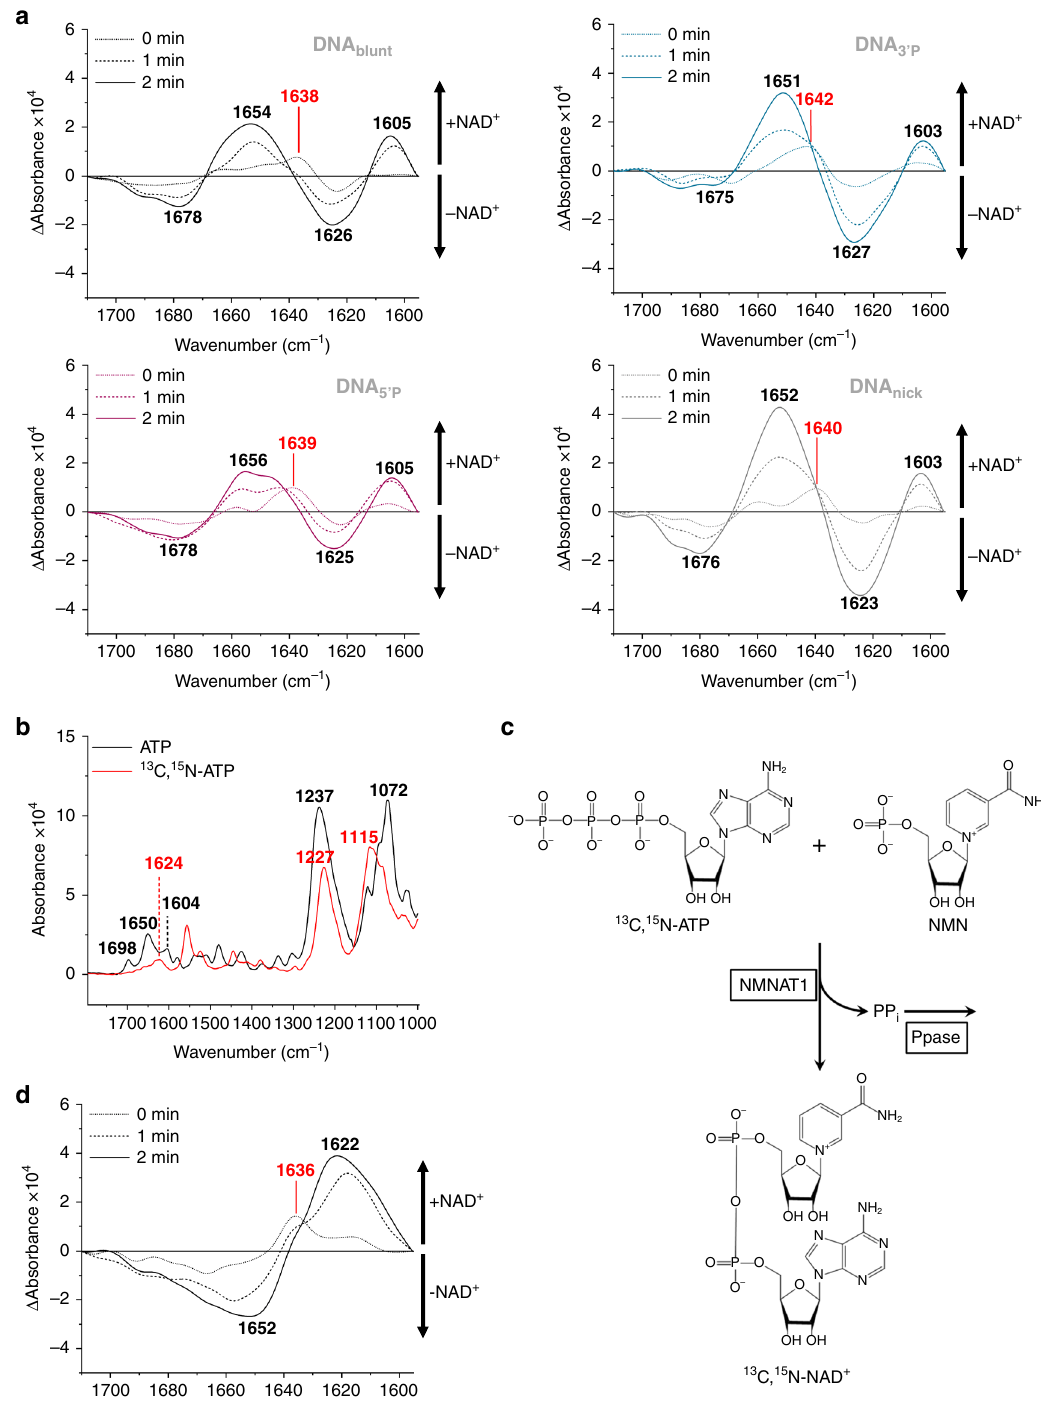
Fig. 5 Secondary structure analysis of PARP1 upon NAD + addition. a Comparison of PARP1 bound to immobilised DNA blunt , DNA 3 ’ P , DNA 5 ’ P or DNA nick . Difference spectra of amide I bands of PARP1 before and after the addition of 100 µ M NAD + (0, 1 and 2 min) were calculated. Average curves of n = 3 independent experiments are plotted, respectively. SDs are shown in Supplementary Fig. 4a. Positive difference bands distinct from PAR bands are indicated in red. b Spectra of unlabelled and isotopically labelled 13 C, 15 N-ATP. c Strategy for the enzymatic synthesis of isotopically labelled 13 C, 15 N-NAD + . d Difference spectra of amide I bands of PARP1 bound to DNA blunt before and after the addition of 100 µ M 13 C, 15 N-NAD + (0, 1 and 2 min) were calculated. Average curves of n = 3 independent experiments are plotted. SDs are shown in Supplementary Fig. 4d. The positive difference band distinct from the PAR band is indicated in red. Source data are provided as a Source Data fi